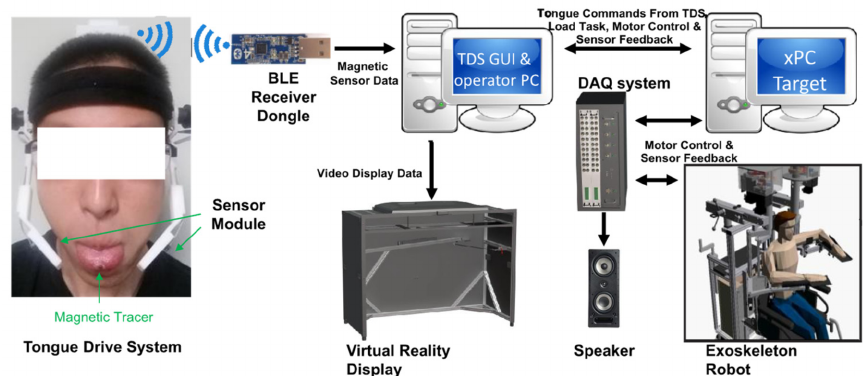
Figure 1. Functional block diagram of the TDS-KA system. Tongue movements are captured using a magnetic tracer on the tongue and a headset with magnetic sensors. The magnetic sensor data corresponding to the tongue position are transferred to a LabVIEW based graphical user interface (GUI) on a PC via Bluetooth low energy connection. The magnetic sensor data are further converted to either discrete commands (rest, left, right, up or down) [45] or proportional commands (a continuous number from − 1 to 1) to control the exoskeleton robot via xPC target computer. At the same time, the robot operator PC controls a virtual reality display directly and the robot via a xPC target computer. The xPC target computer interacts with the exoskeleton robot via a data acquisition board (DAQ) and generates the sound queue of the task via a connected speaker. The subject’s image is published with written informed